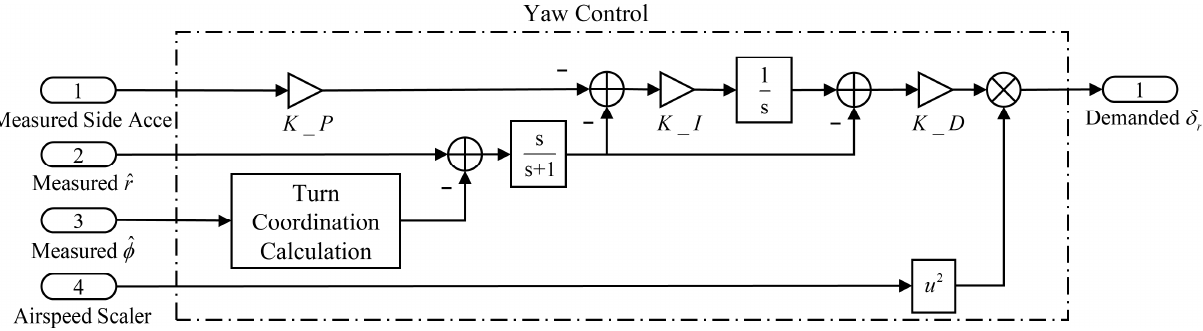
Figure 8. Yaw control loop schematic diagram.